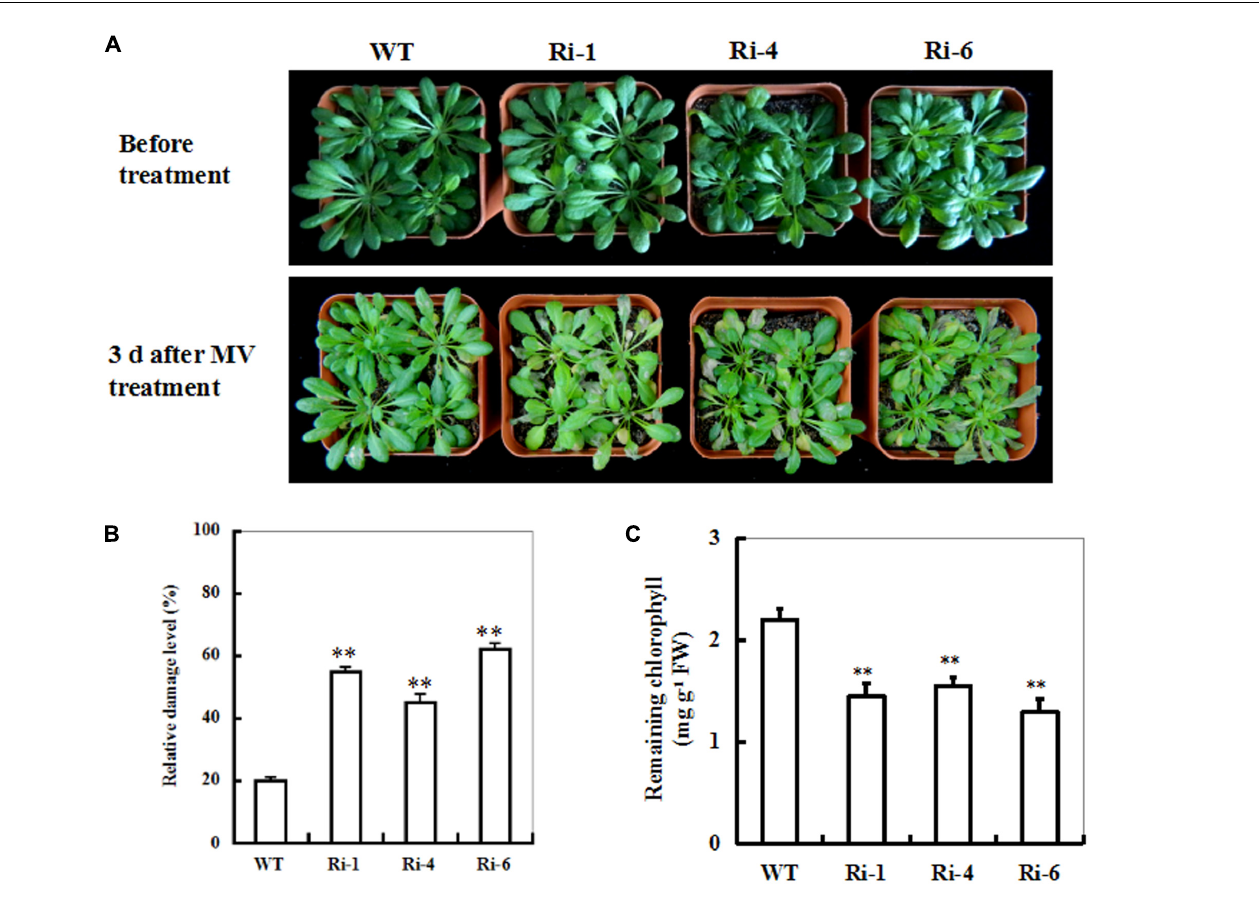
FIGURE 3 | Responses of wild-type and SiR under-expressing plants to oxidative stress. (A) Toxic effect of MV on WT and SiR RNAi plants. Five-week-old WT and RNAi lines (Ri-1, Ri-4 and Ri-6) were sprayed with 20 µ M of MV and examined 3 days later. (B) Relative damage level in the wild-type and RNAi plants after MV exposure. Values are mean ± SE, n = 20. ∗∗ t -test, with P < 0.01. (C) Residual chlorophyll in the wild-type and RNAi lines after MV exposure. Values are mean ± SE, n = 20. ∗∗ t -test, with P <